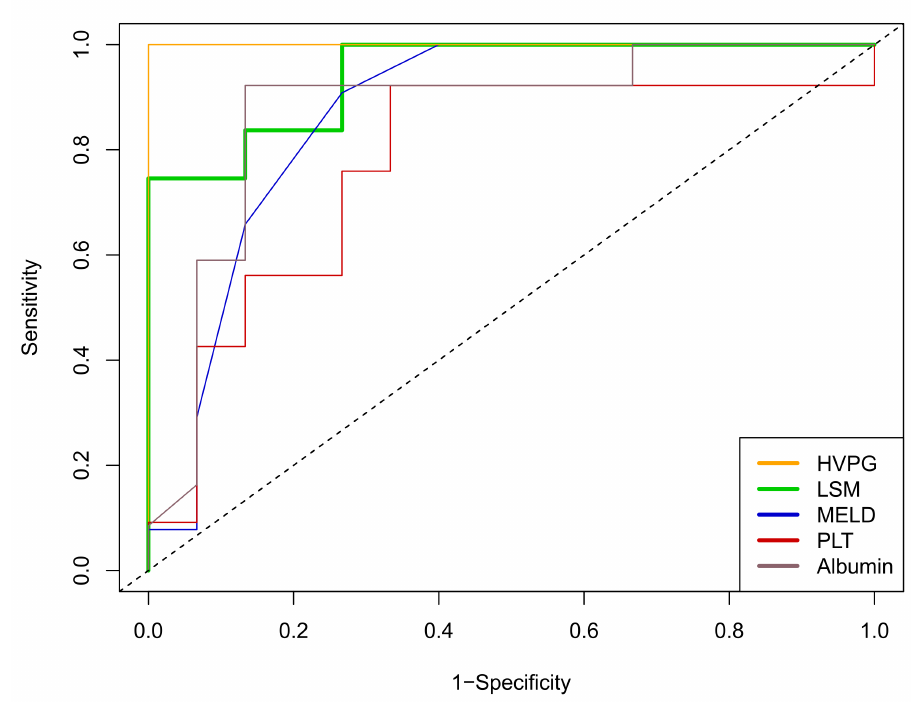
Figure 2. Time-dependent receiver operating characteristic curves for the prediction of (further) hepatic decompensation within three years of follow-up by HVPG (AUROC = 1.000 (95%CI 1.000–1.000); n = 17), LSM (0.944 (0.868–1.000)), MELD (0.869 (0.729–1.000)), PLT (0.775 (0.586–0.964), inverse association) and albumin levels (0.873 (0.727–1.000), inverse association). Abbreviations: HVPG = hepatic venous pressure gradient; LSM = liver stiffness measurement; MELD = model for end-stage liver disease score; PLT = platelet count; AUROC = area under the receiver operating characteristics